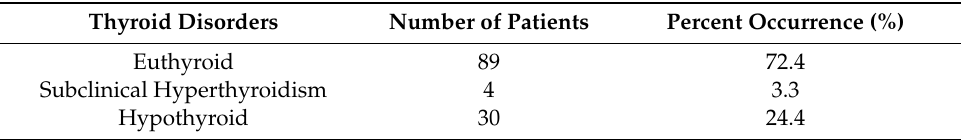
Table 2. Frequency of thyroid disorders among the group.